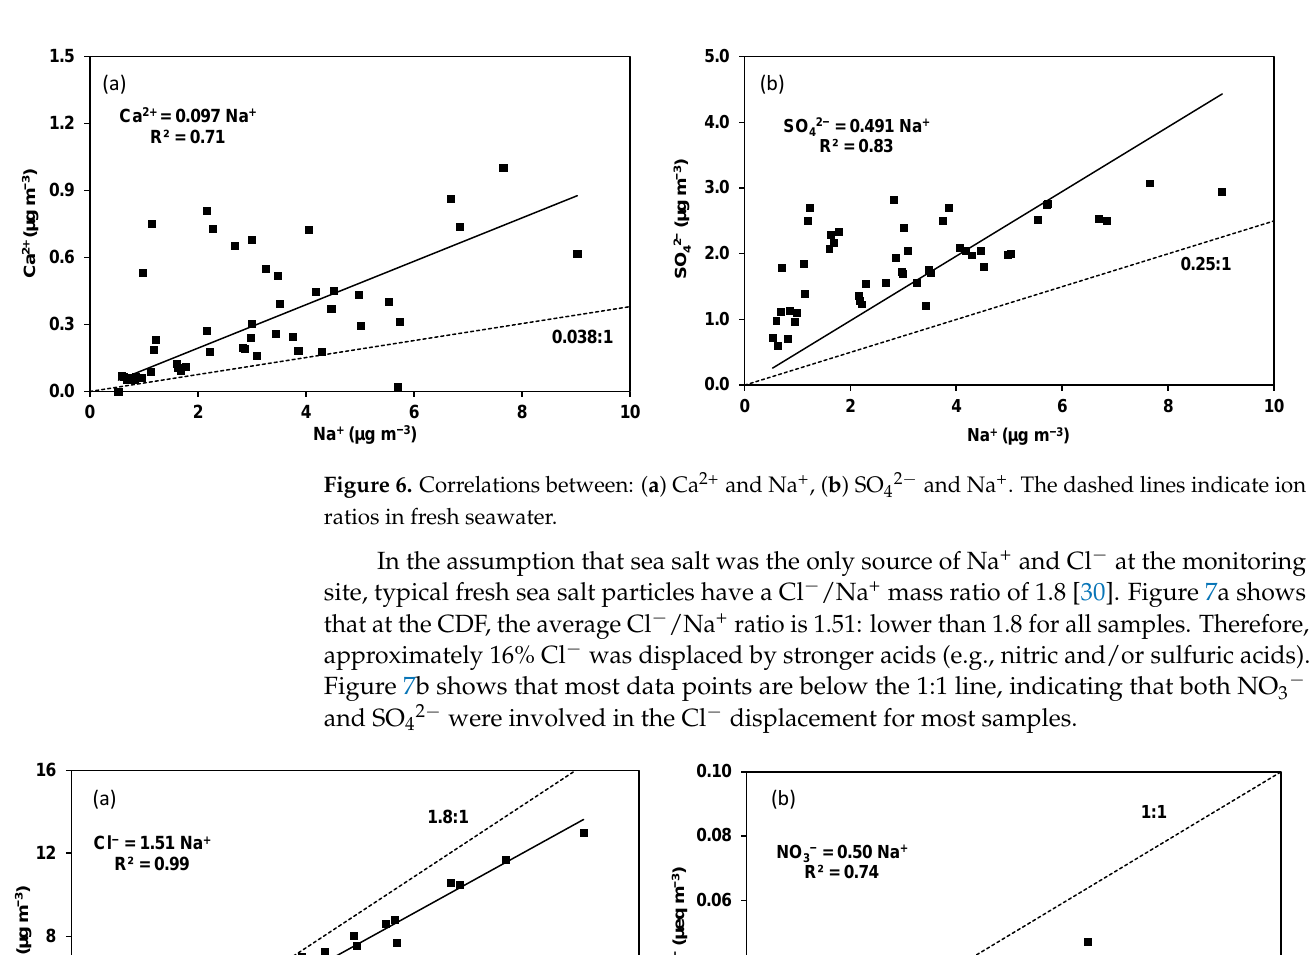
PM 10 concentrations are lower than approximately 40 μg m −3 , and the ratio remains <0.2